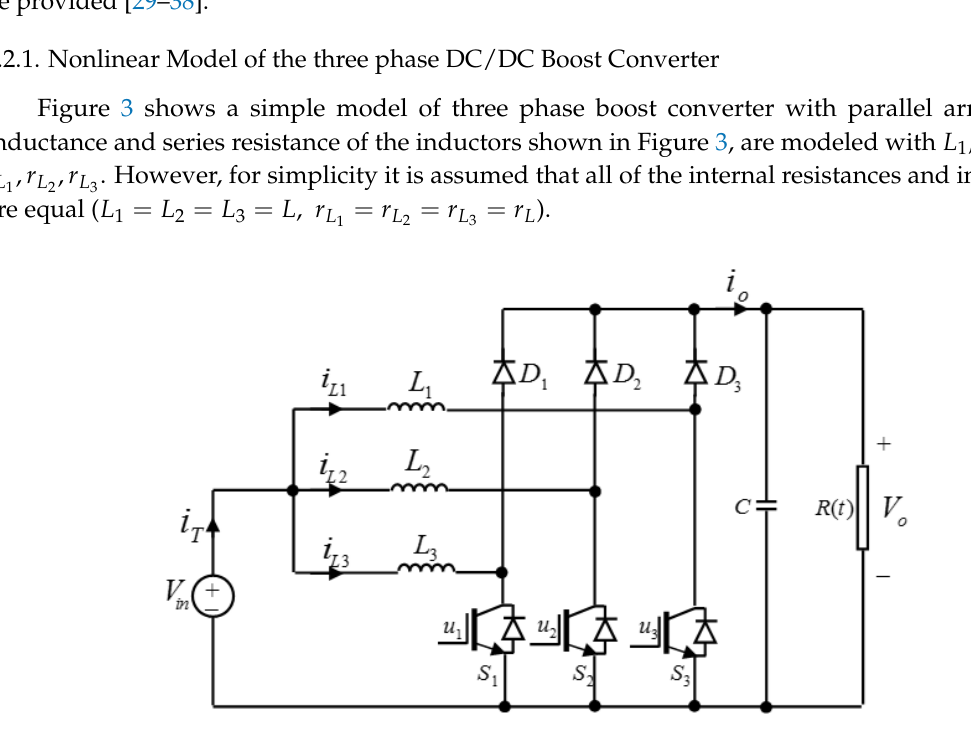
Figure 3. Power circuit of three phase boost converter with parallel arrangement